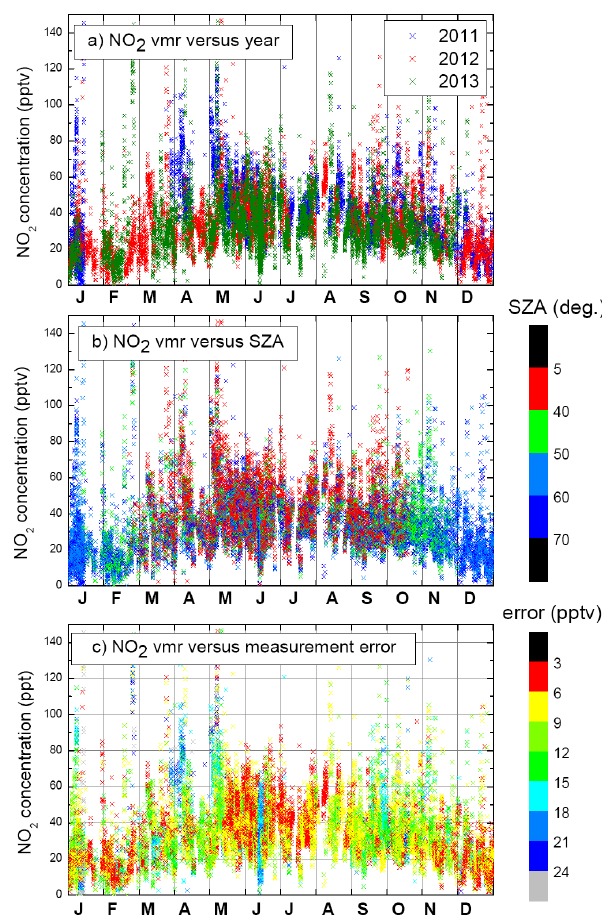
Figure 5. Seasonal evolution of the individual data NO 2 vmr sepa- rated by (a) years, (b) solar zenith angles and (c) RMSE.